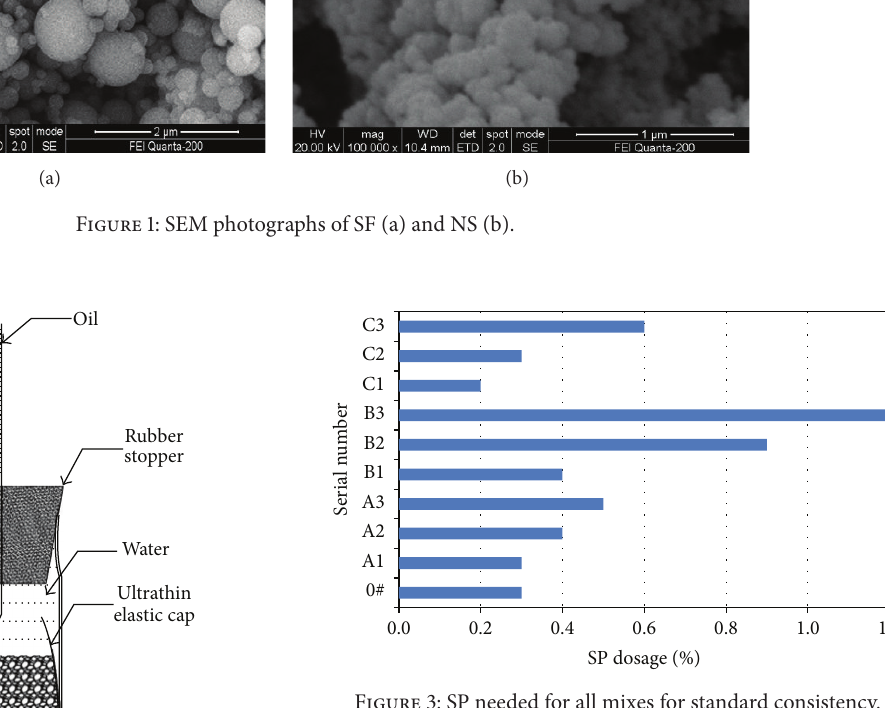
Figure 3: SP needed for all mixes for standard